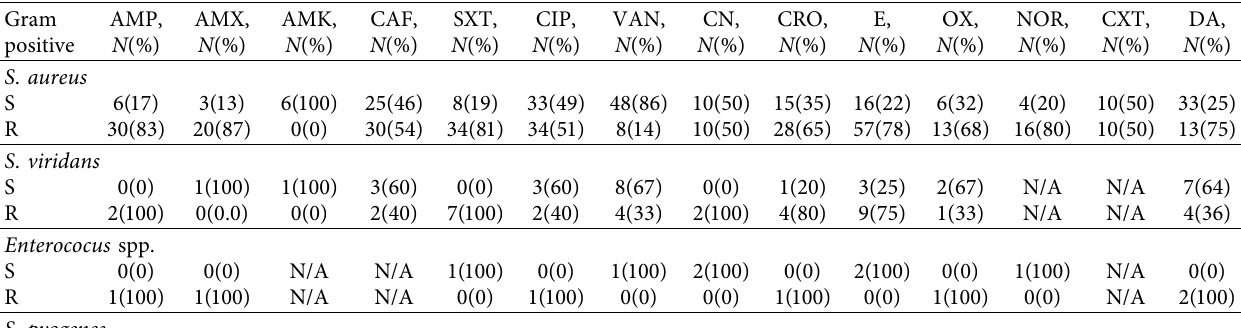
Table 4: Antimicrobial susceptibility profile of Gram-positive bacterial isolates at University of Gondar Comprehensive Specialized Hospital, Northwest